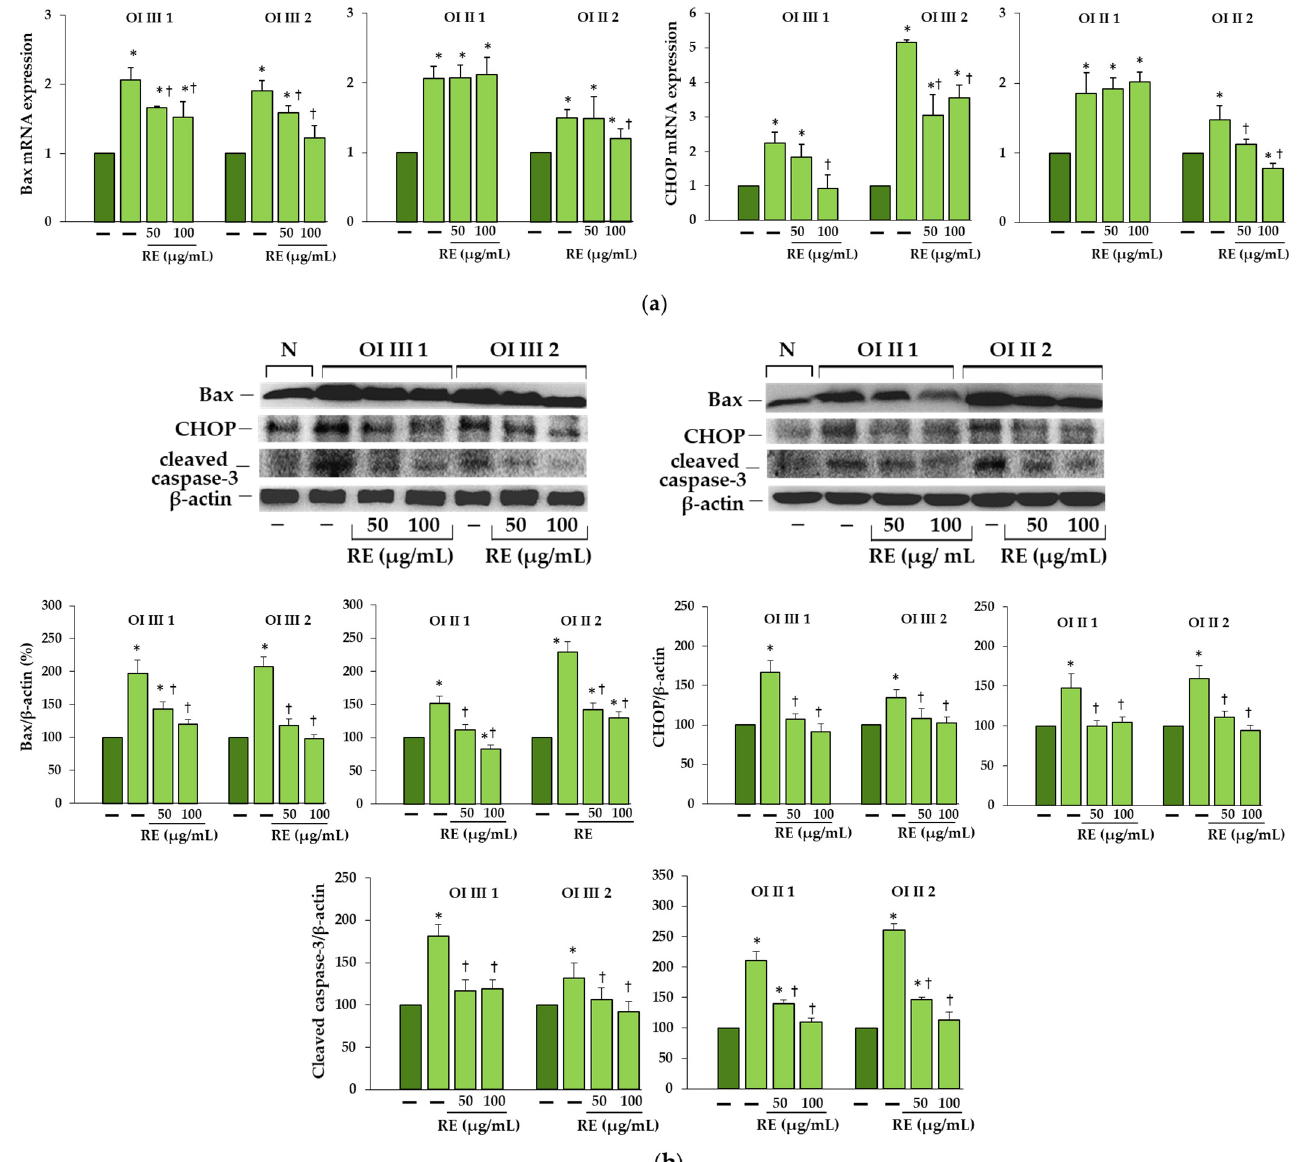
Figure 9. ( a ) The effect of rosemary extract (RE) on mRNA relative expression of Bax and CCAAT enhancer binding protein (CHOP) in OI types III and II cells. The bars represent the results of the mean values from three independent experiments; * p < 0.05, OI cells vs. normal cells; † p < 0.05, OI treated cells vs. OI untreated cells; dark green and light green bars represent normal and OI, respectively. ( b ) Western blot analysis of Bax, CHOP and cleaved caspase-3 in OI type III and II cells; β -actin was used as cell protein loading control. The bars represent the results as the mean values from three independent experiments; * p < 0.05, OI cells vs. normal (N) cells; † p < 0.05, OI treated cells vs. OI untreated cells. The data are expressed as a percentage of the normal sample taken as 100%; dark green and light green bars represent normal and OI,